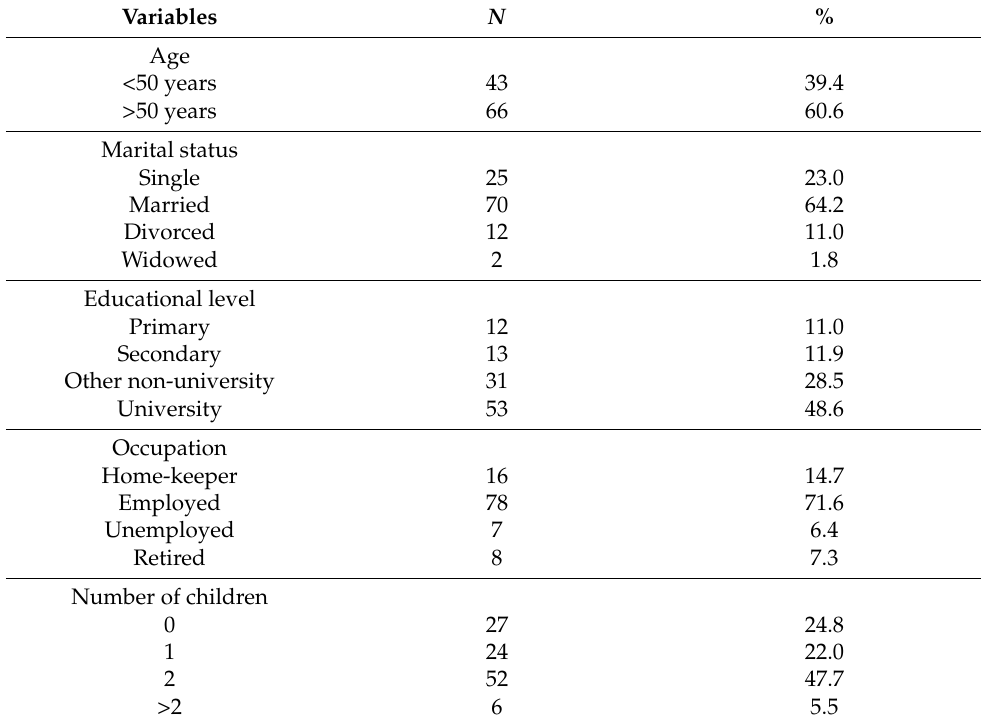
Table 1. Sample characteristics ( N =